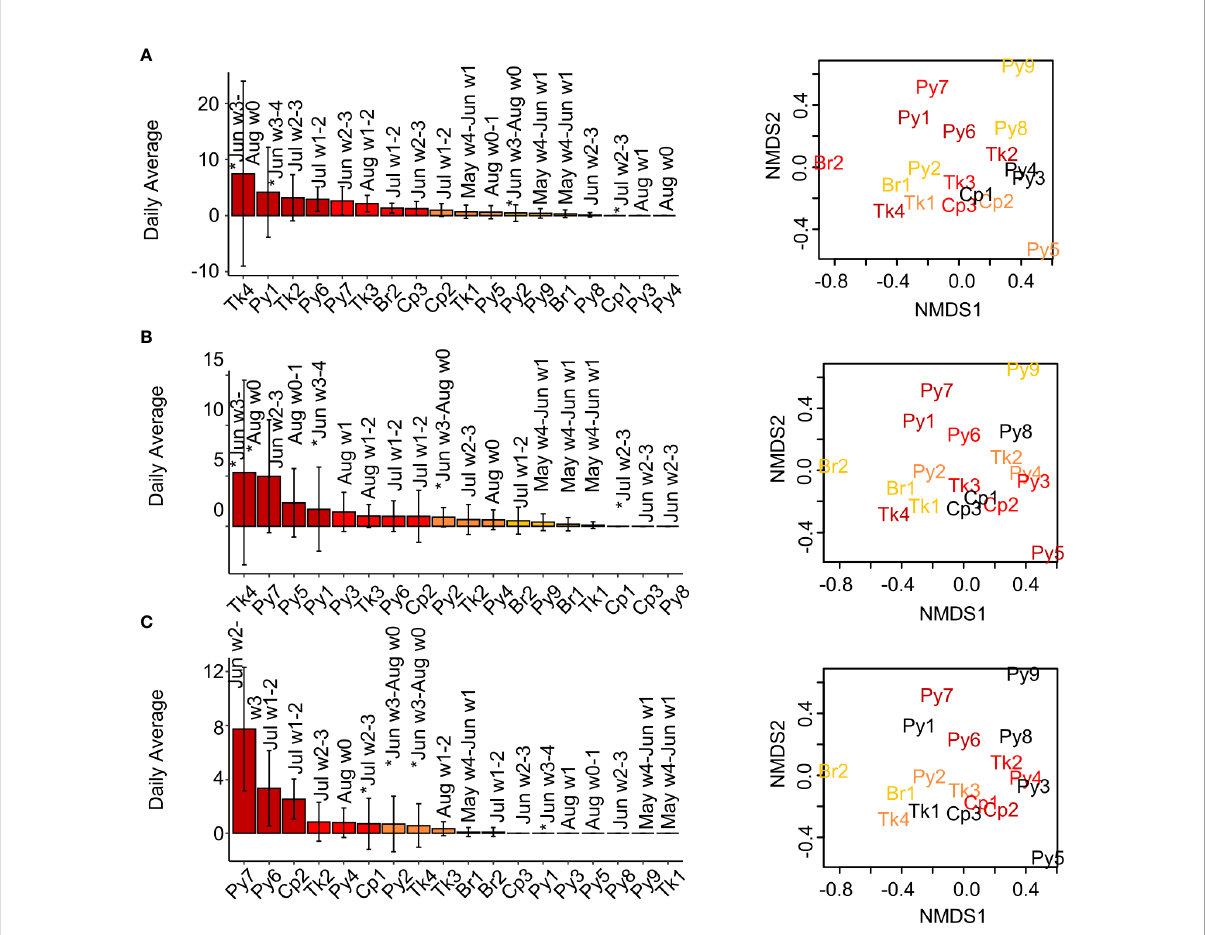
FIGURE 6 Daily low-frequency sound rates (average ± SD) among reefs and sound rate associations with fi sh species abundance and composition. Sounds detected by templates (A) LF1, (B) LF4, and (C) LFP. Month and week number (1-4) of the month the reef is sampled are indicated above the bars. Reefs sampled in 2018 are indicated on the month of sampling with an asterisk. nMDS plots of (dis)similarity of fi sh species presence/ absence among reefs based are shown right (stress = 0.166), with reef abbreviations in colors indicating reefs in which this sound type was detected. Plots are repeated for each row (sound type) with colors assigned for that sound type. Colored bars and text from dark red to yellow indicate the relative call rates among reefs with > 0 calls, from high to low. Dark red = call rates in 100-75 th percentile, red-orange = call rates from 50-74.9 th percentile, orange = call rates from 25-49.9 th percentile, yellow = call rates from 0-24.9 th percentile, black = no calls detected on that